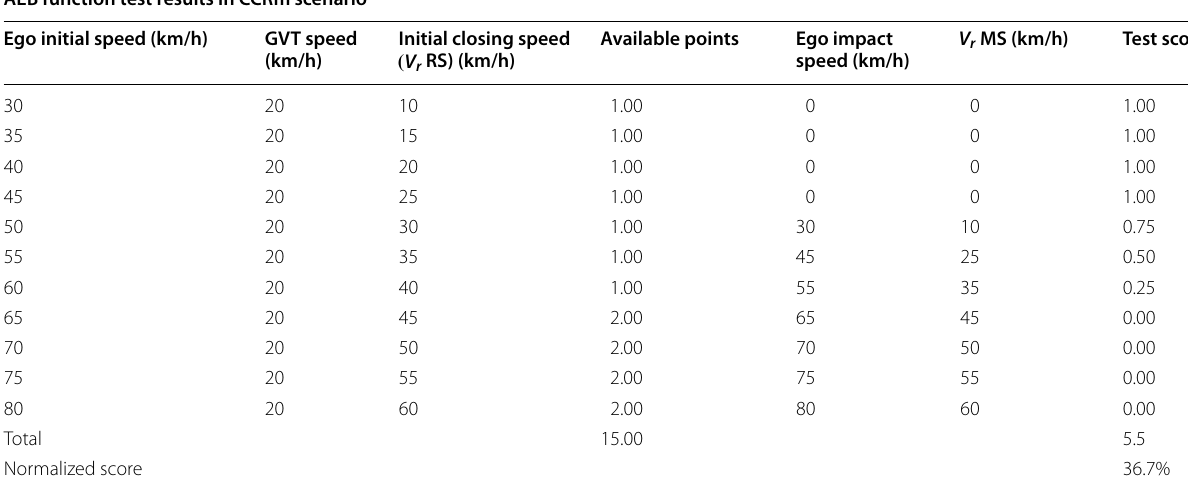
Table 1 Results of a hypotetical Car-to-Car Rear moving test with 0% offset AEB function test results in CCRm